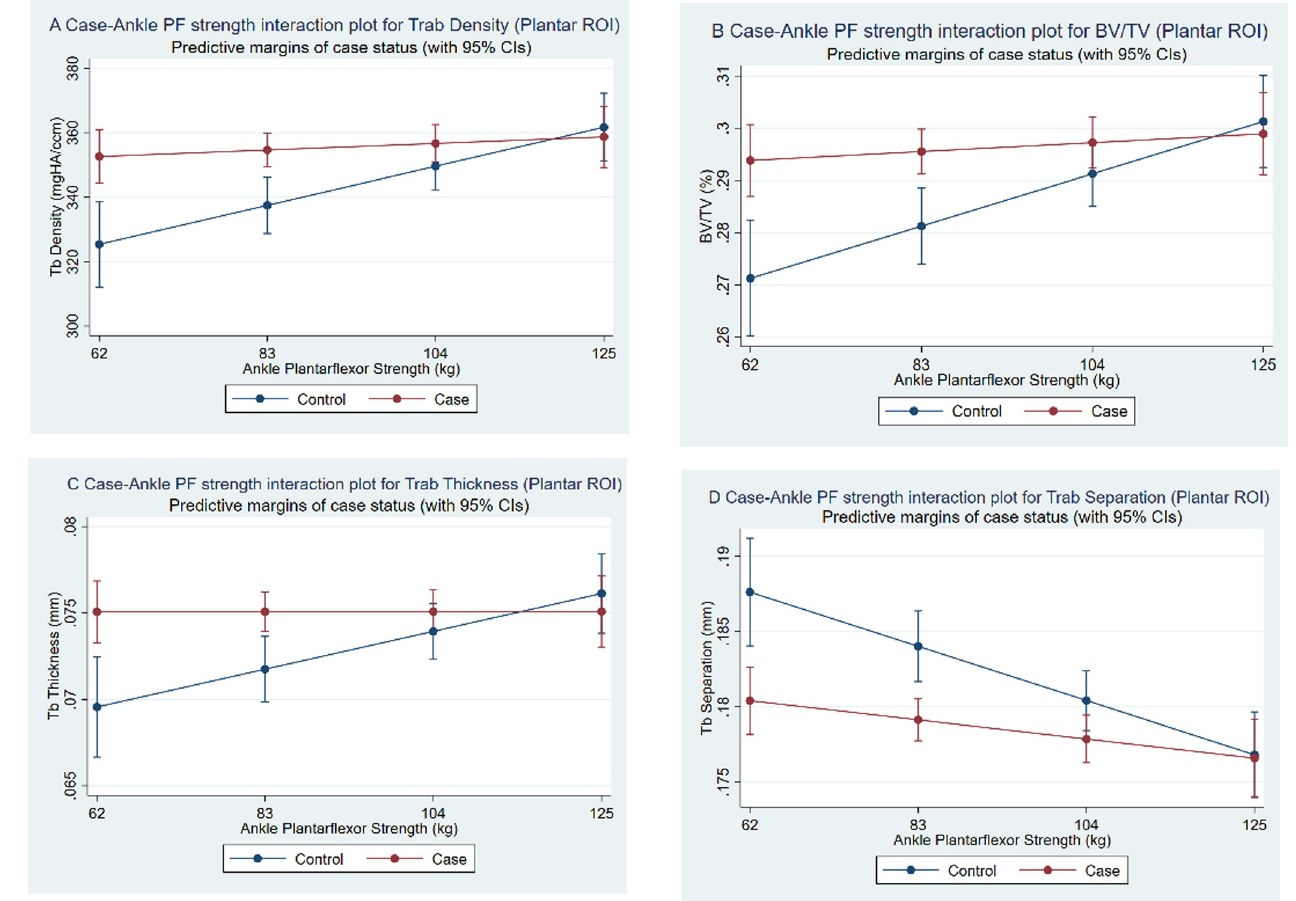
Fig 4. (A) Case-ankle plantarflexor strength interaction plot for plantar ROI trabecular density, (B) BV/TV, (C) thickness and (D) separation. Bone outcomes plotted from the 10th to 90th percentile of ankle plantarflexor